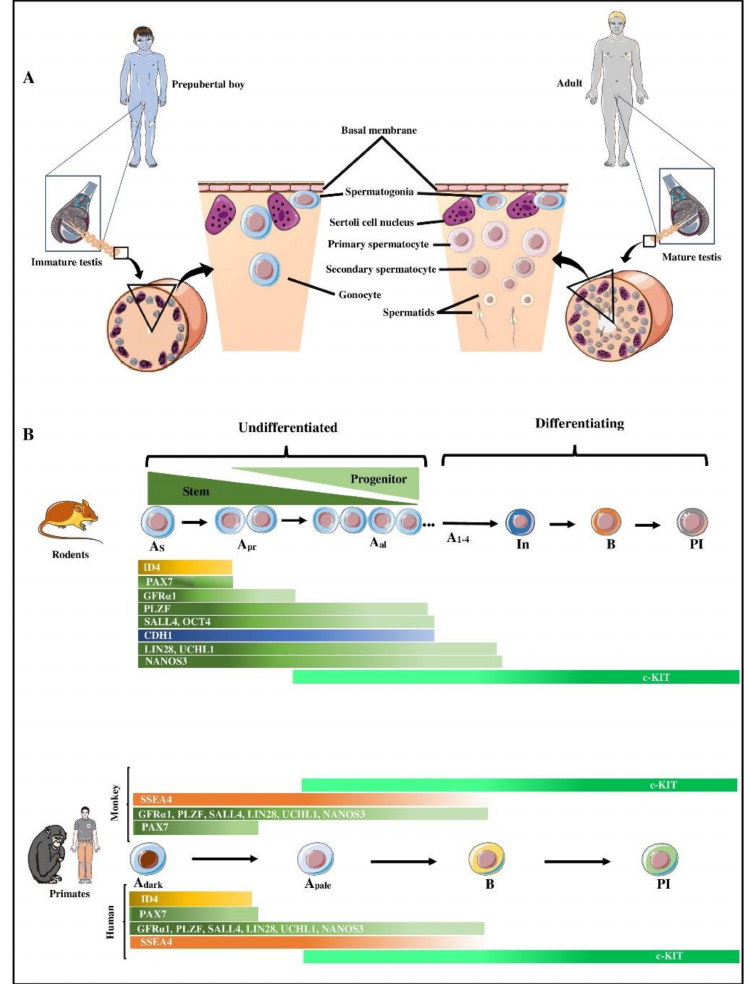
Figure 1. Schematic representation of various spermatogenic cells present in the prepubertal and adult testis, as well as comparative representation of spermatogonial markers in rodents and primates. ( A ) A schematic pie slice of a seminiferous cord / tubule of a human prepubertal and an adult showing the di ff erent types of spermatogenic cells present. Gonocytes or spermatogonia (depending on age) are the only types of germ cells present in the testis of prepubertal boys, whereas in the adult testis all stages of spermatogenic cells can be present. Spermatogonia reside at the basal membrane and are intra-tubularly surrounded by Sertoli cells. Spermatogonia undergo di ff erentiation into spermatocytes, spermatids, and ultimately sperm. ( B ) Comparative developmental patterns and expression profile of select spermatogonial markers in rodents and primates. Rodents and primates have several common spermatogonial markers (green color-coded) with few exceptions (blue, orange, and gold-coded). For a more complete list of the currently-known molecular markers of rodent and primate spermatogonia see Table 1. A s : Type A-single spermatogonia; A pr : Type A-paired spermatogonia; A al : Type A-aligned spermatogonia; A dark : Type A spermatogonia with dark nuclei; A pale : Type A spermatogonia with pale nuclei; In: intermediate spermatogonia; B: Type B spermatogonia; Pl: preleptotene